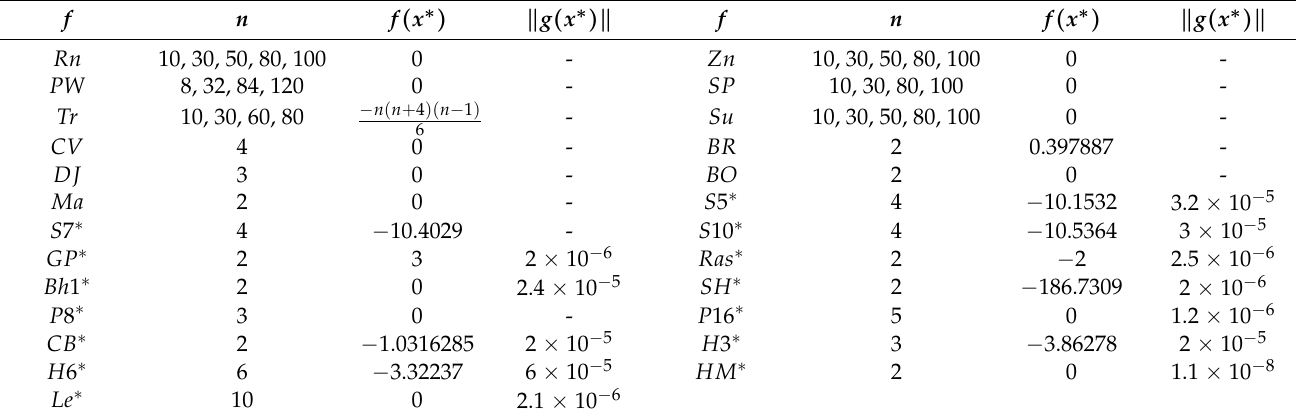
Table 1. List of both kinds of test problems.